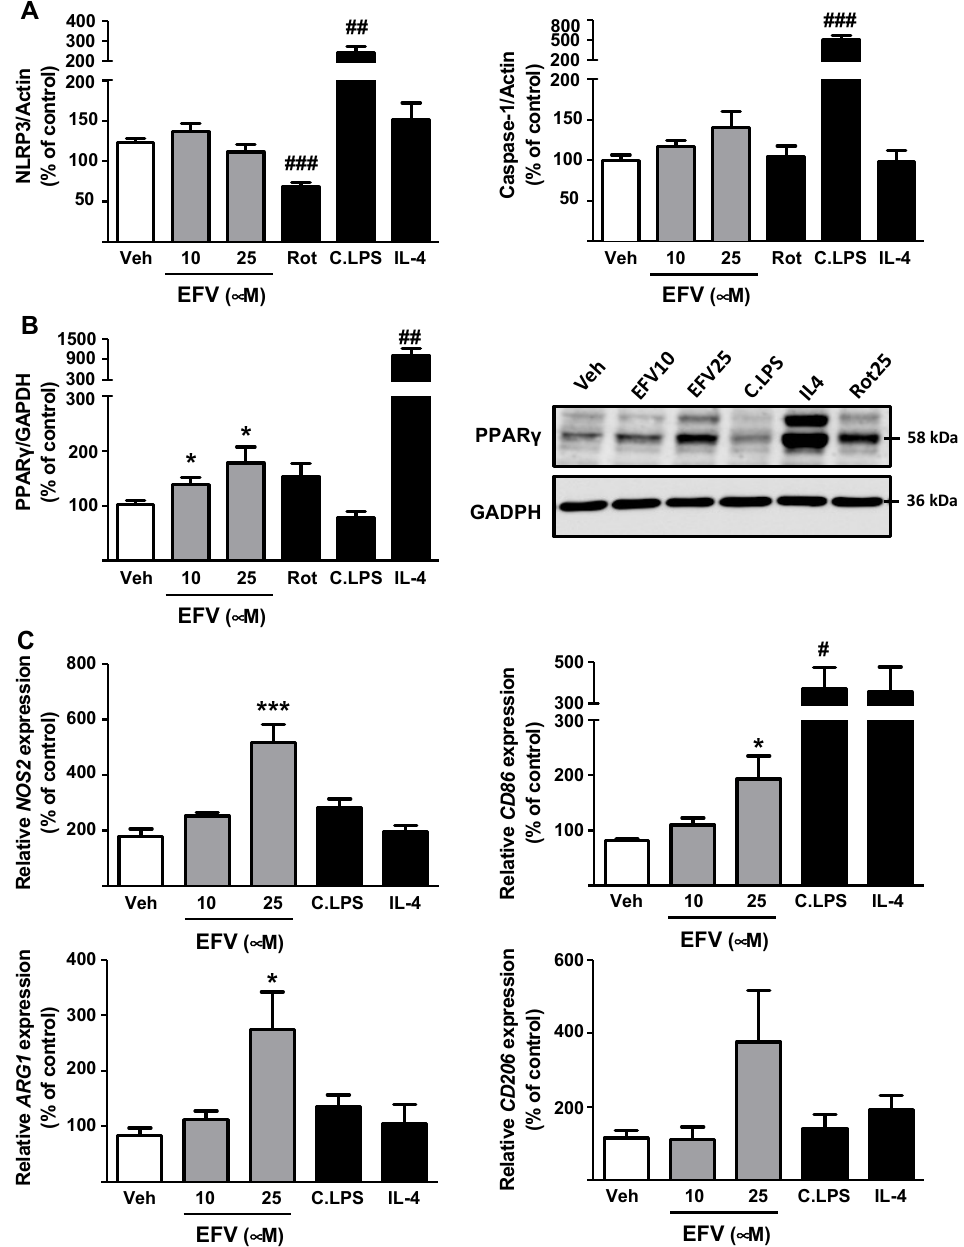
Figure 6. Efavirenz induces anti-inflammatory pathways in macrophages. ( A ) Determination of protein expression of NLRP3 and Caspase-1 (n = 8–10). ( B ) Representative Western Blot image of PPAR γ and summary of densitometry data obtained from independent experiments after 24 h of treatment (n = 5). ( C ) Analysis of relative mRNA expression levels of M1 ( NOS2 and CD86 ) and M2 markers ( ARG1 and CD206 ) by RT-PCR. Data were normalized versus the housekeeping gene β -actin (n = 5–6). Data were represented as mean ± SEM, were calculated as a percentage of control (untreated cells) and analyzed by a one-way ANOVA multiple comparison test followed by a Newman–Keuls test (* p < 0.05, *** p < 0.001 versus the respective solvent). Positive controls employed (rotenone -Rot-, cocktail of LPS -C.LPS- and interleukin 4 -IL-4-,) were independently analyzed by a Student’s t -test ( # p < 0.05, ## p < 0.01, ### p < 0.001).